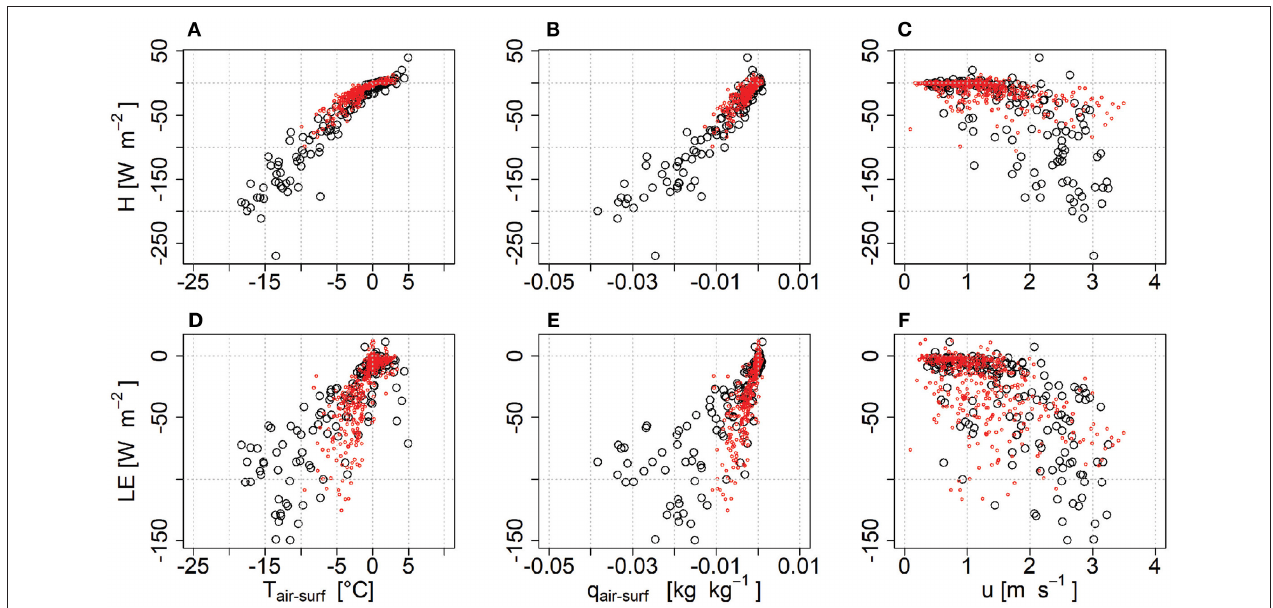
FIGURE 6 | Half-hourly values for temperature difference between air and surface measurements (A,D) as well as specific humidity with the assumption of full saturation of the surface (B,E) and wind speed (C,F) compared to sensible (A–C) and latent heat flux (D–F) . Red dots represent overcast while black dots represent clear sky